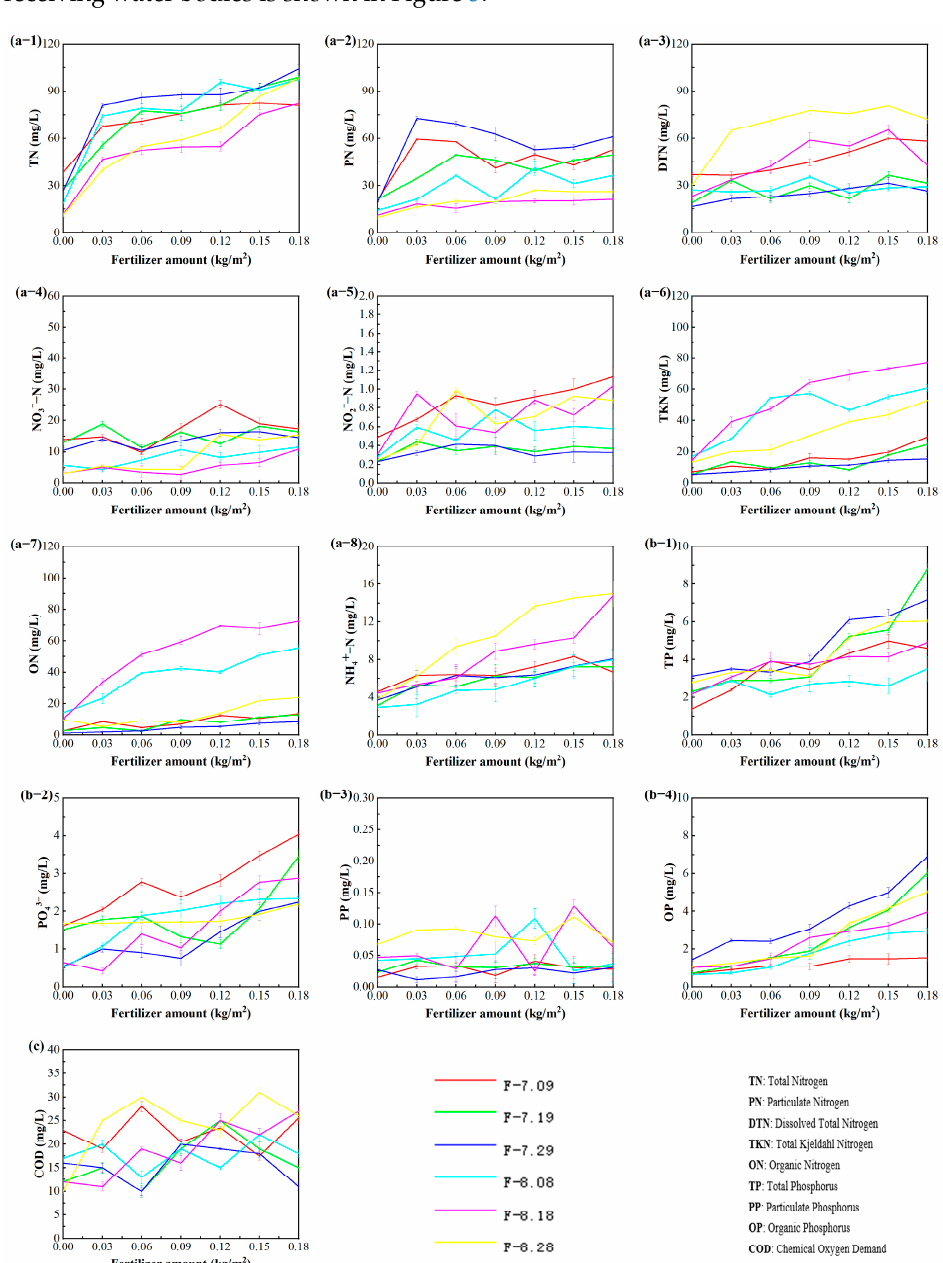
Figure 5. Relationship between fertilizer amount and pollutant concentration in runoff. With the increase in fertilizer application amount, the TN and TP concentrations in the receiving water body showed an increasing trend, and at 0.18 kg/m 2 , the TN and TP concentrations were the largest at 93.7 mg/L and 5.85 mg/L, which were 318.0% and 151.0% larger than the CK group, respectively, and the COD concentration did not change significantly at 15.0 mg/L~20.4 mg/L. For nitrogen pollutants, the order of pollutant con- centrations in the water column was DN > PN > TKN > ON > NO 3 − -N > NH 4+ -N > NO 2 − -N except for TN, where the concentration of NO 2 − -N was extremely low, only 1/100 of TN. Among the top four nitrogen pollutants with larger concentrations, TKN and ON were similar to TN in terms of concentration changes, and gradually increased with the increase in fertilizer application, and at 0.18 kg/m 2 , the concentrations of TKN and DN were the largest, 43.4 mg/L and 43.3 mg/L, respectively, which were 303.2% and 70.0% larger than the CK group, respectively. Among these pollutants, OP and PO 43 − were similar to TP and